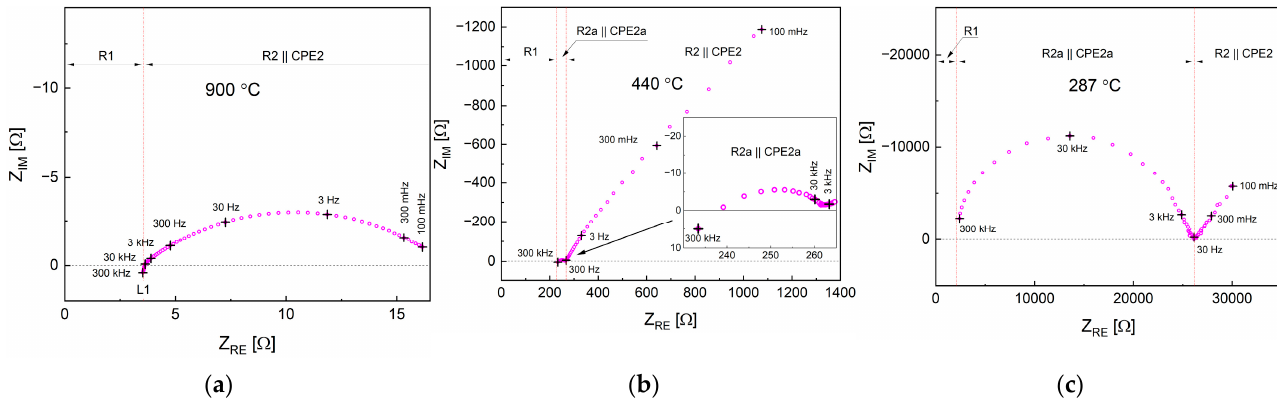
Figure 7. Exemplary electrochemical impedance curves recorded for Pr005|LSGM|Pr005 cell at ( a ) 900 °C, ( b ) 440 °C, and ( c ) 287 °C in air.